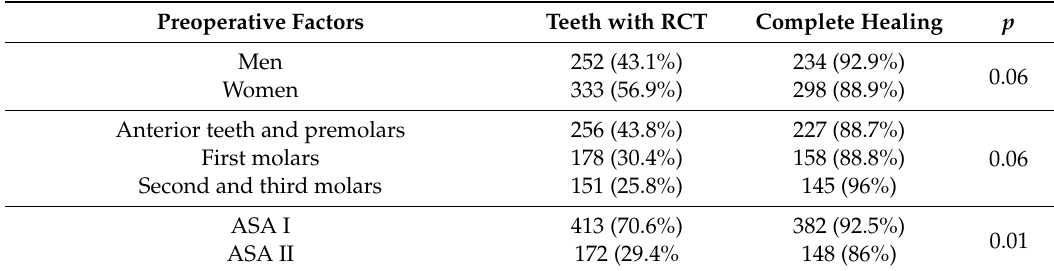
Table 1. Registered preoperative